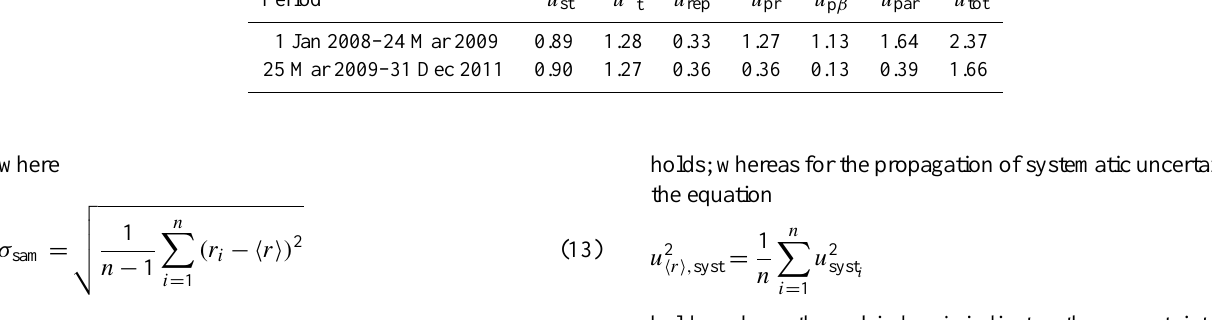
Table 2. Mean values of the uncertainty components (in nmolmol − 1 ) before and after March 2009. Period u st u